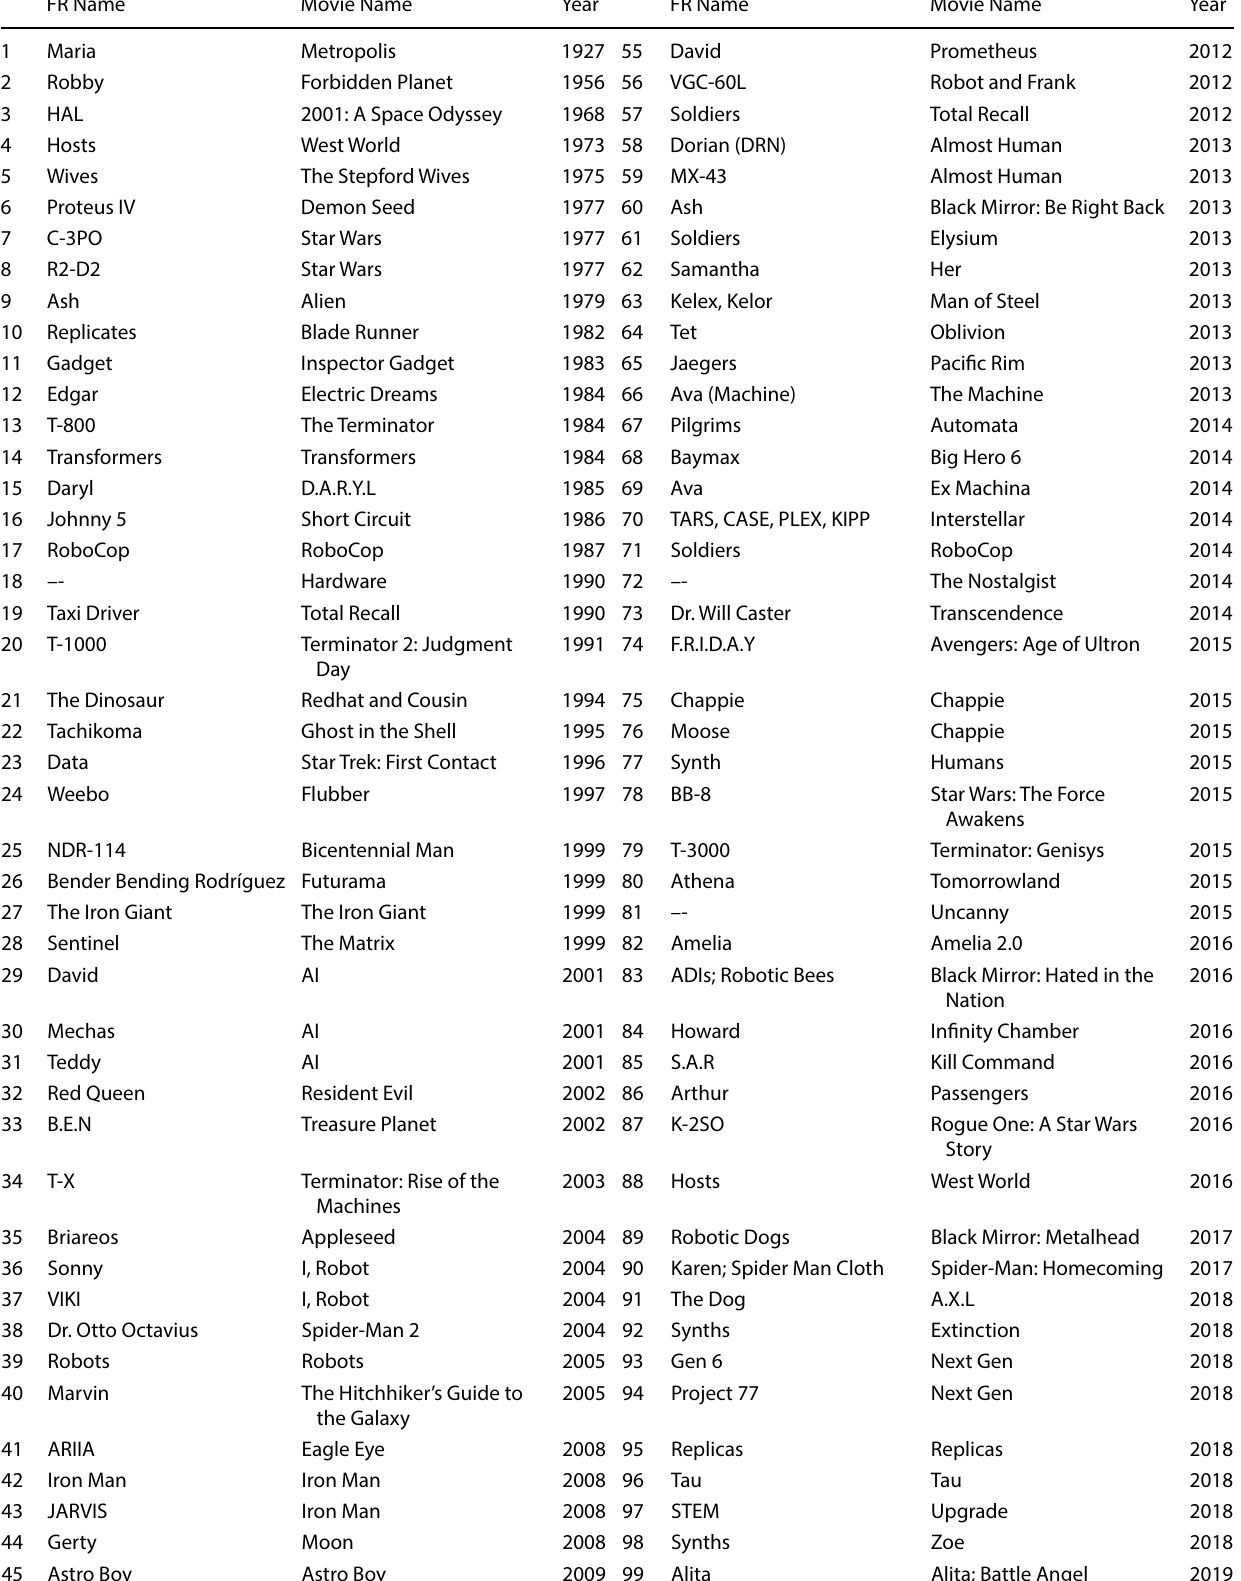
Table 1 List of the Investigated Fictional Robots including the movie’s name they present and the year of first